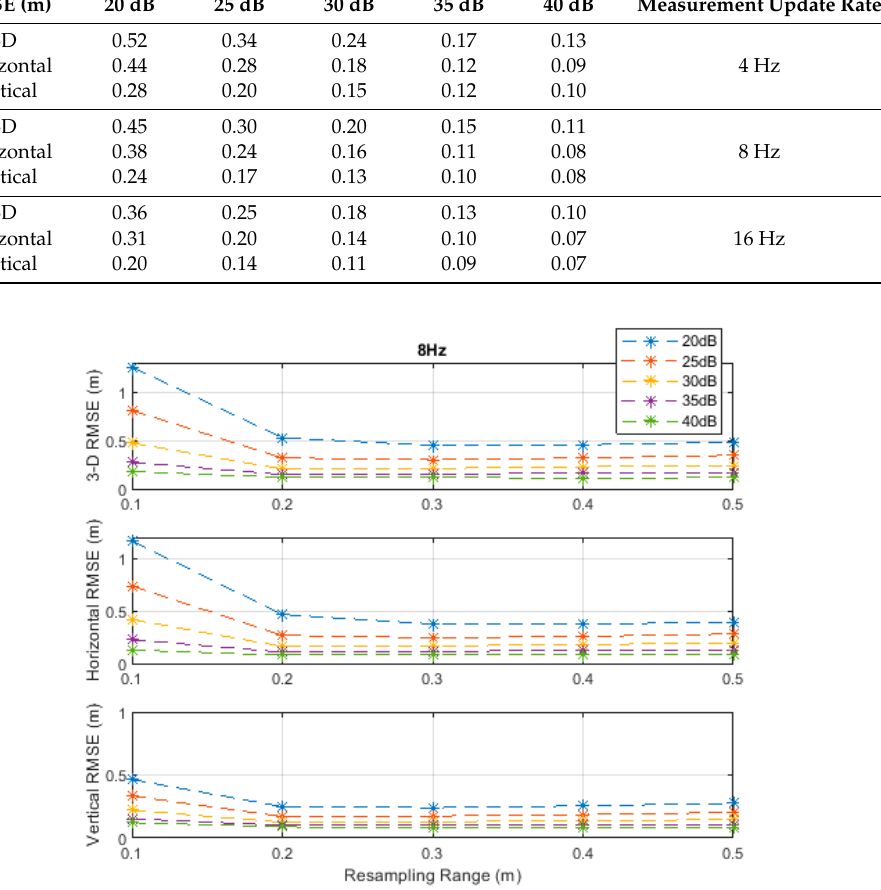
Figure 16. RMSE results along the helical path at a measurement update rate of 8 Hz.